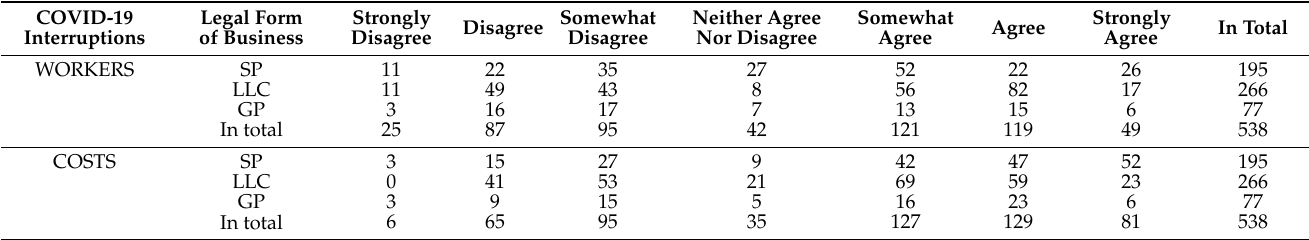
Table A2. The distribution of answers for COVID-19 interruptions by the type of the form of legal businesses (number of